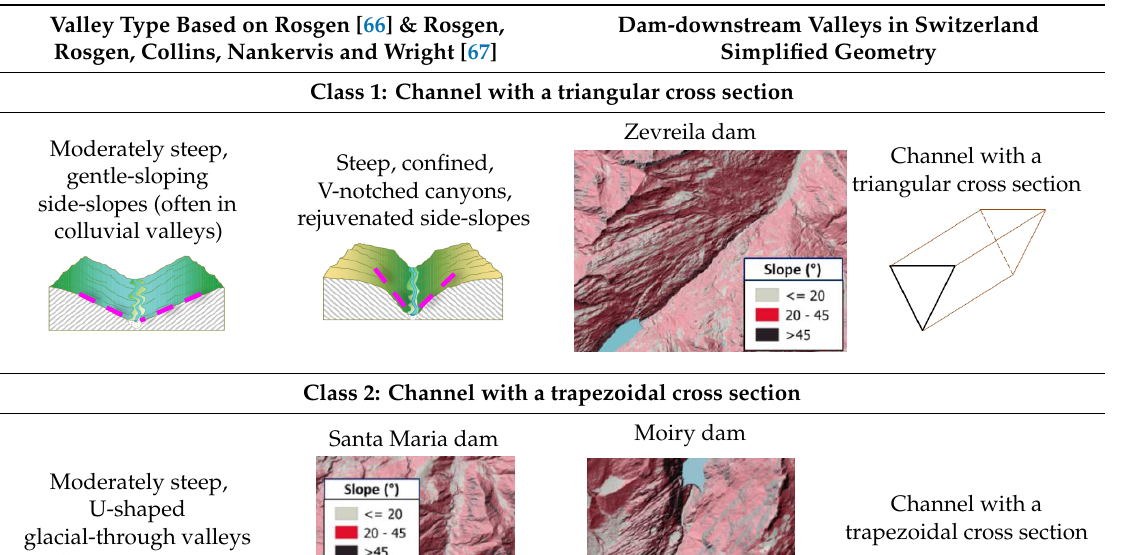
Class 2: Channel with a trapezoidal cross section